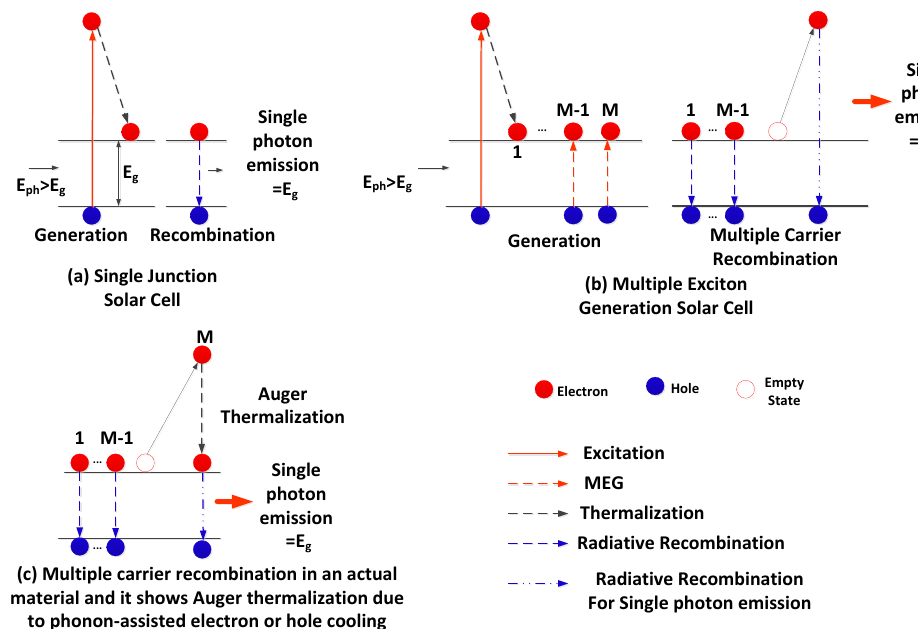
Figure 1. Carrier generation and recombination process of a single-junction solar cell (SJSC) and multiple exciton generation solar cell (MEGSC). ( a ) One electron and hole pair (EHP) generation and recombination of SJSC. ( b ) Multiple EHP generation process by impact ionization and multiple carrier recombination process after Auger recombination (AR) where M is the maximum generated EHPs (1, 2, 3, ... , M − 1, M). ( c ) Multiple carrier recombination and Auger thermalization via phonon-assisted electron or hole cooling after a carrier